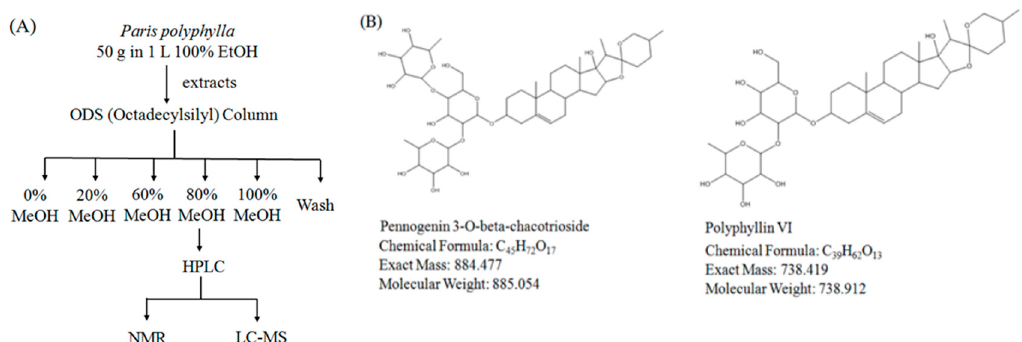
Figure 5. Isolation of active ingredients from EEPP. ( A ) The flowchart for identification of active compounds obtained from EEPP. ( B ) Pennogenin 3- O -beta-chacotrioside and polyphyllin VI were isolated and confirmed by NMR and LC–MS.